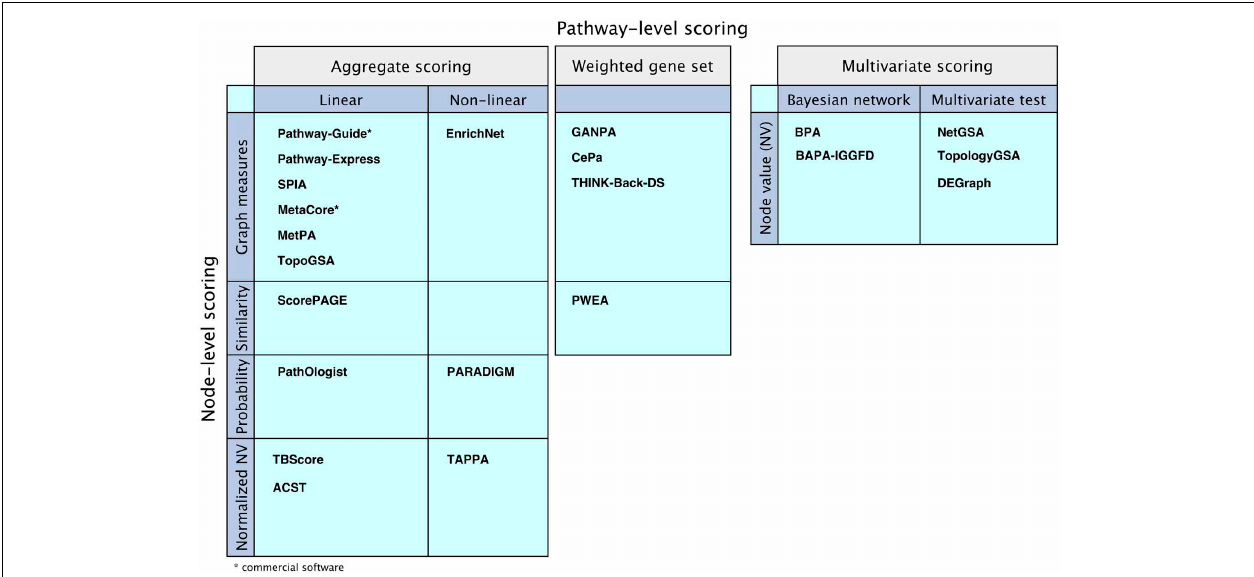
measure techniques, similarity measurement techniques, probabilistic models, or using normalized node values based on node value and/or pathway structure. The “Multivariate scoring” methods use multivariate scoring models without node-level scoring. They use node values to directly compute a pathway score using Bayesian networks or applying multivariate hypothesis